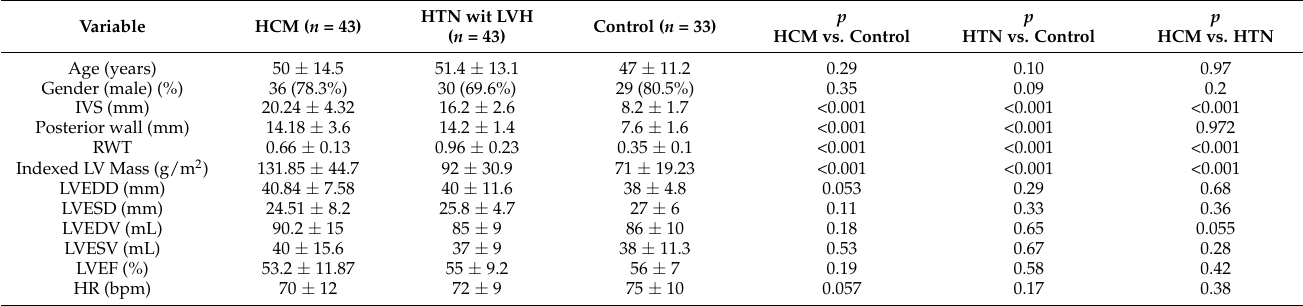
Table 1. Comparison of demographic and conventional echocardiographic data among patients with hypertrophic car- diomyopathy (HCM), patients with hypertension (HTN) with left-ventricular hypertrophy (LVH), and controls. Variable HCM ( n = 43) HTN wit LVH ( n = 43) Control ( n = 33)